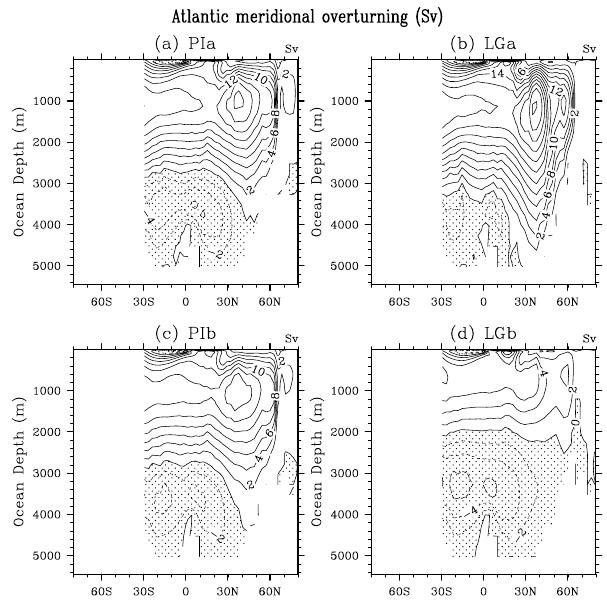
Fig. 2. Meridional overturning stream function (Sv) in the Atlantic Ocean of (a) PIa, (b) LGa, (c) PIb, and (d) LGb. Contour intervals are